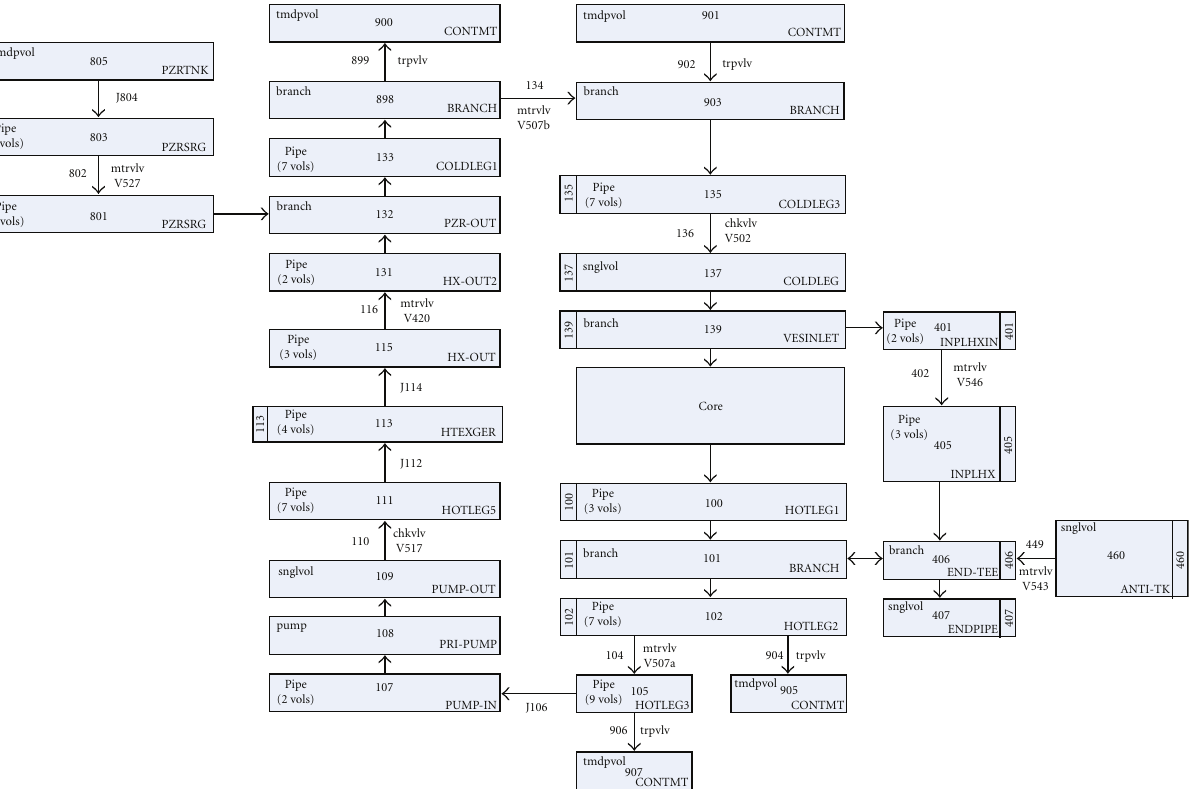
Figure 2: MURR RELAP/SCDAPSIM nodalization of the MURR pressurized primary cooling system.